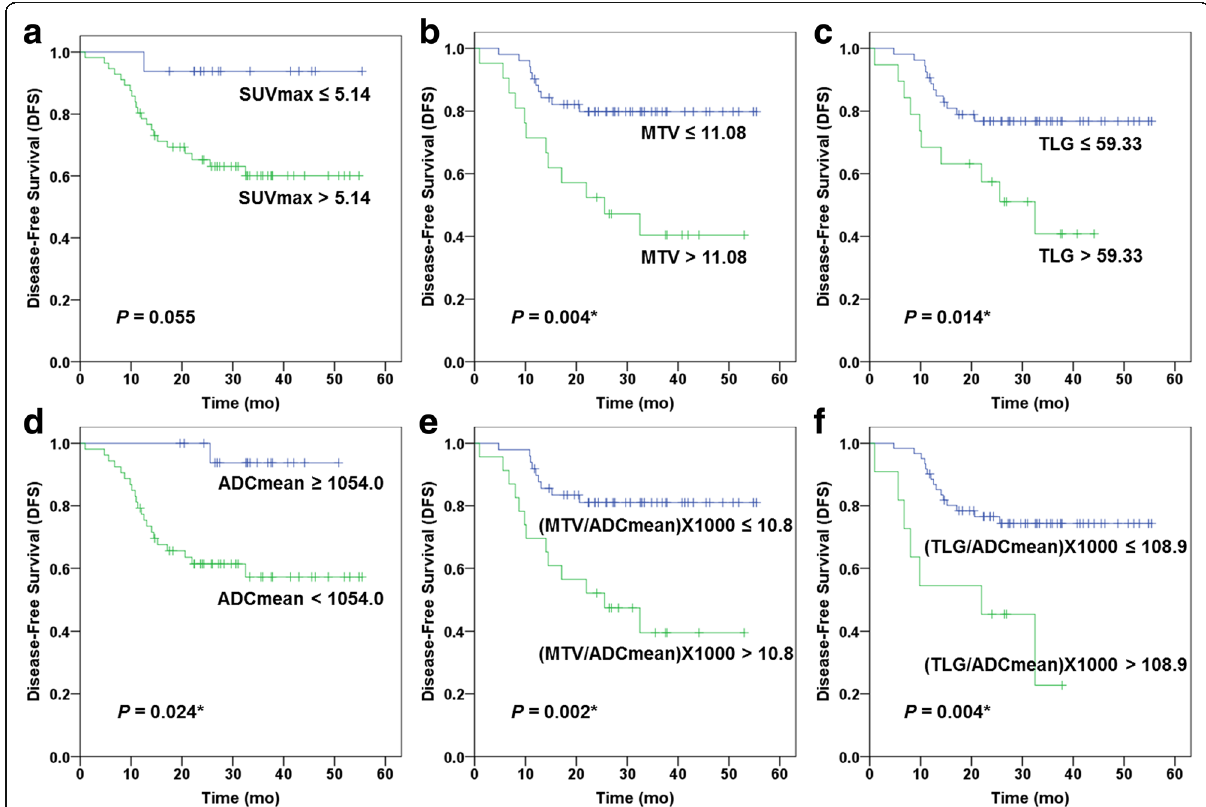
Fig. 2 Kaplan – Meier analysis of 18 F-FDG PET/MRI parameters for prediction of tumor treatment failure after head and neck cancer surgery. DFS and P values were as follows: a SUVmax (3-year DFS=93.8 vs. 60.1%, P =0.055), b MTV (3-year DFS=79.8 vs. 40.4%, P =0.004), c TLG (3-year DFS=76.8 vs. 40.8%, P =0.014), d ADCmean (3-year DFS=93.8 vs. 57.3%, P =0.024), e MTV/ADCmean (3-year DFS=81.1 vs. 39.5%, P =0.002), and f TLG/ADCmean (3-year DFS=74.4 vs. 22.7%; P